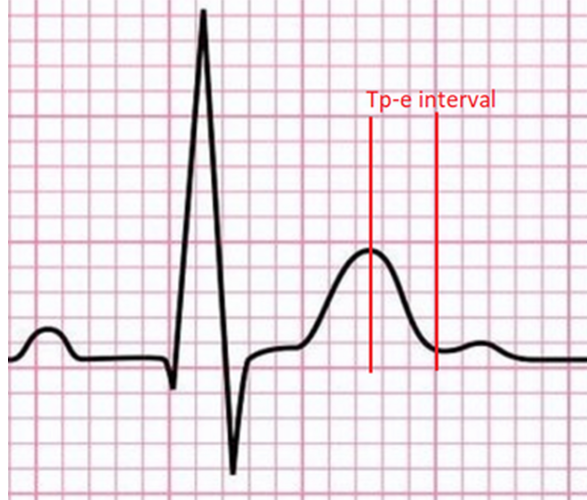
Fig. 2. Measurement of the T peak to end (Tp-e)